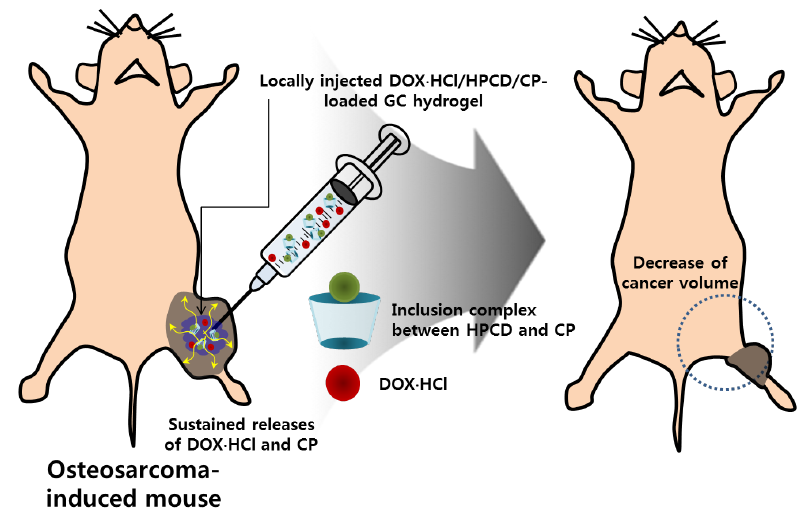
Figure 9. In vivo anticancer effect of GDHCP hydrogel on osteosarcoma. The hydrogel was locally injected into the cancer tissue once a week for 4 weeks.